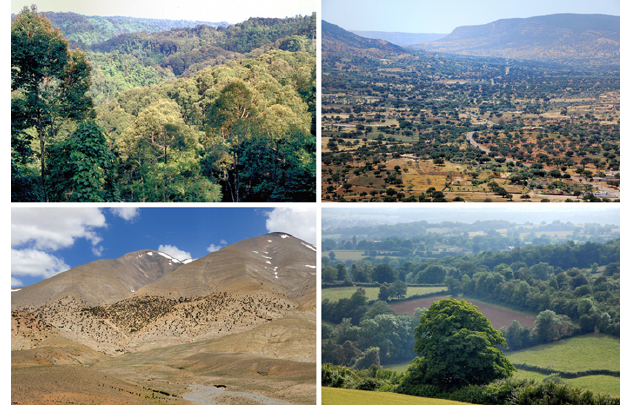
Fig. 7 . Landscape domestication patterns in rural forest systems: from continuous forest cover (above) in the damar agroforest in Indonesia (left) and in the argan forest in southwestern Morocco (right) to forest fragments (forest “agdal” in the Moroccan High Atlas: below, left, and linear forests and woodlots in Central France: below